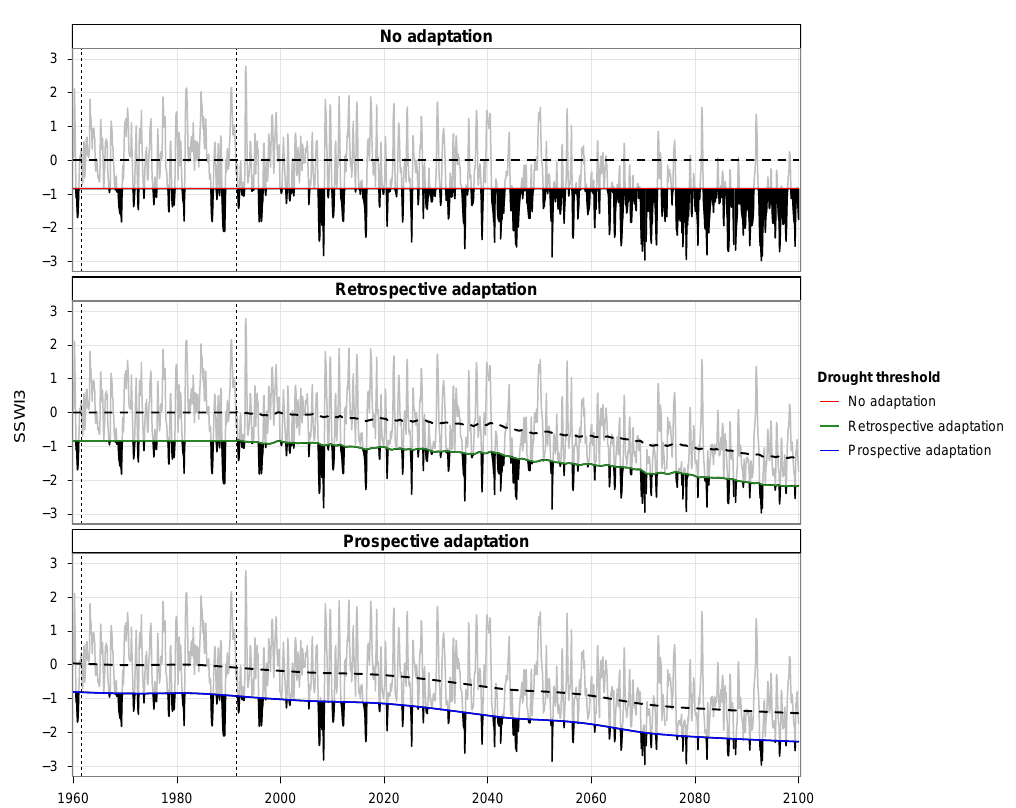
Fig. 1. Evolution of SSWI3 for a grid cell near Toulouse under the A1B scenario, and corresponding adaptation scenarios. Black filled areas correspond to local-scale drought events reaching the 20% threshold. The dashed lines show the drought index baseline evolutions calculated for each adaptation scenario and described in Table 3. Coloured lines show the corresponding drought state threshold (see text for details). The reference period is framed by dashed vertical